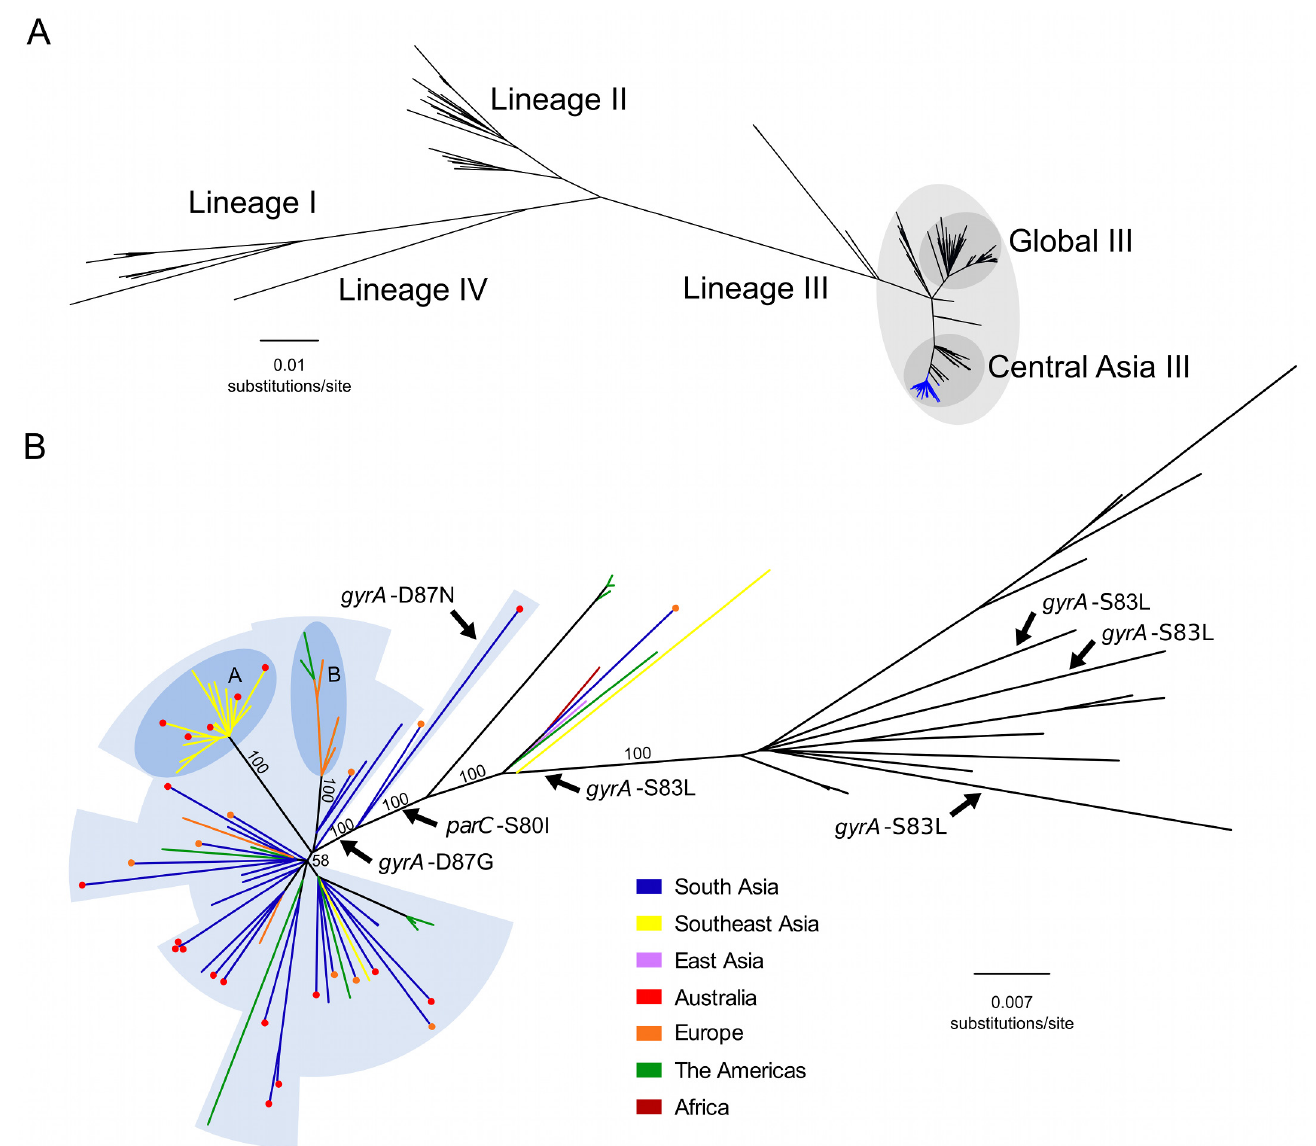
Fig 1. The phylogenetic structure of ciprofloxacin-resistant Shigella sonnei in an international context. A) Unrooted maximum likelihood phylogeny of 211 globally representative S . sonnei , including 60 sequences from ciprofloxacin-resistant isolates (highlighted by the blue branches). Major lineages are indicated by numbers (I, II, III, and IV) as defined in Holt et al. 2012, with clades Global III and Central Asia III within lineage III highlighted. Horizontal scale bar indicates the number of nucleotide substitutions per site. B) Unrooted maximum likelihood phylogeny of Central Asia III, composed of 97 S . sonnei sequences. Branch colours indicate region of isolation (where no travel history is confirmed) or region of recent travel (where travel history was confirmed) according to the keys. For isolates with confirmed recent travel, a coloured circle at the tip indicates the region where the isolate was collected (multiple coloured circles are indicative of multiple isolates). Labelled arrows indicate branches where the mutations gyrA -S83L, gyrA -D87N, gyrA -D87G, and parC -S80I have arisen. Blue background shading denotes isolates exhibiting ciprofloxacin resistance conferred by triple mutations ( gyrA -S83L, parC -S80I, and gyrA -D87G [or gyrA -D87N]). Subpopulations A and B are highlighted in the darker blue shaded areas, denoting clonal expansions in Southeast Asia and Europe/America, respectively. Numbers above major branches indicate bootstrap support values, and horizontal scale bar denotes the number of nucleotide substitutions per